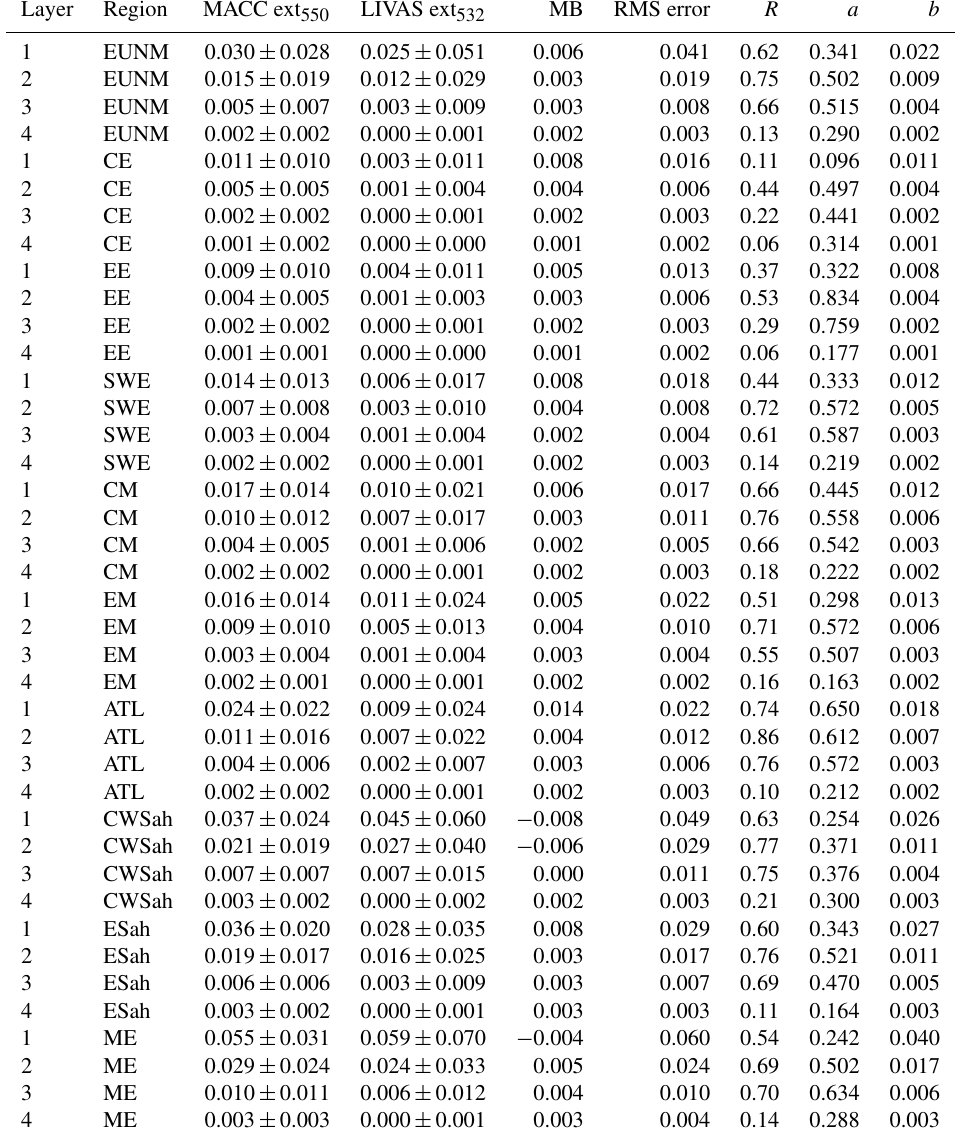
Table 2. MACC dust extinction coefficient at 550nm (in km − 1 ) ( ± 1 σ ) and LIVAS dust extinction coefficient at 532nm (in km − 1 ) ( ± 1 σ ), as well as MACC–LIVAS MB and RMS error, slope and intercept of the MACC–LIVAS linear regression line, and the corresponding correlation coefficient R for the Europe–northern Africa–Middle East (EUNM) domain and for the nine subregions of interest for layer